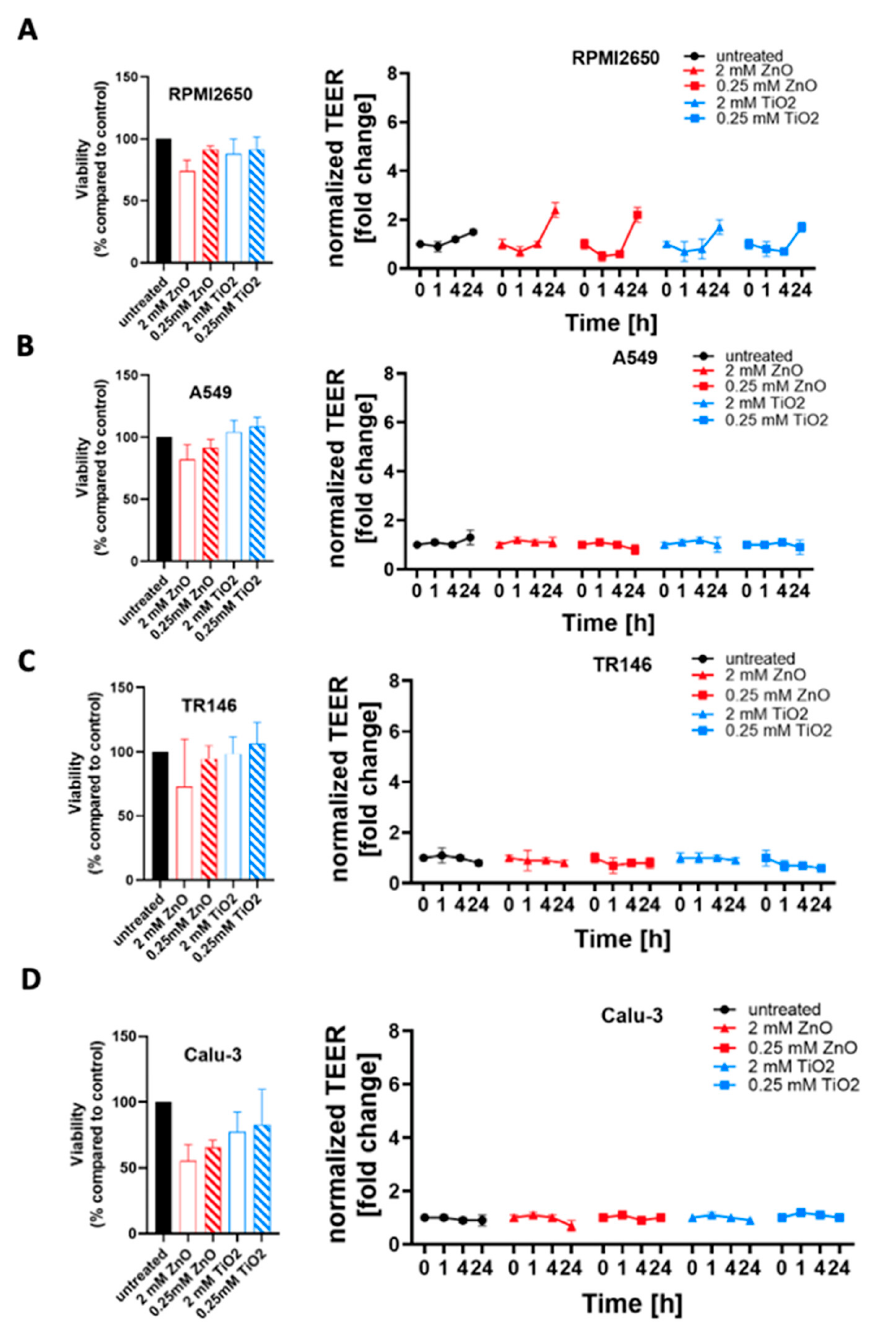
Figure 7. Comparison of zinc oxide and titanium dioxide nanoparticle toxicity in dependence of culture technique. Cell viability was measured after 24 h incubation with nanoparticles, measured using a Presto Blue Assay, ( A ) RPMI2650, ( B ) A549, ( C ) TR146, and ( D ) Calu-3. Data are expressed as mean ± standard deviation for n = 3 replicates. Two-way ANOVA with Tukey posthoc multi- comparisons test.